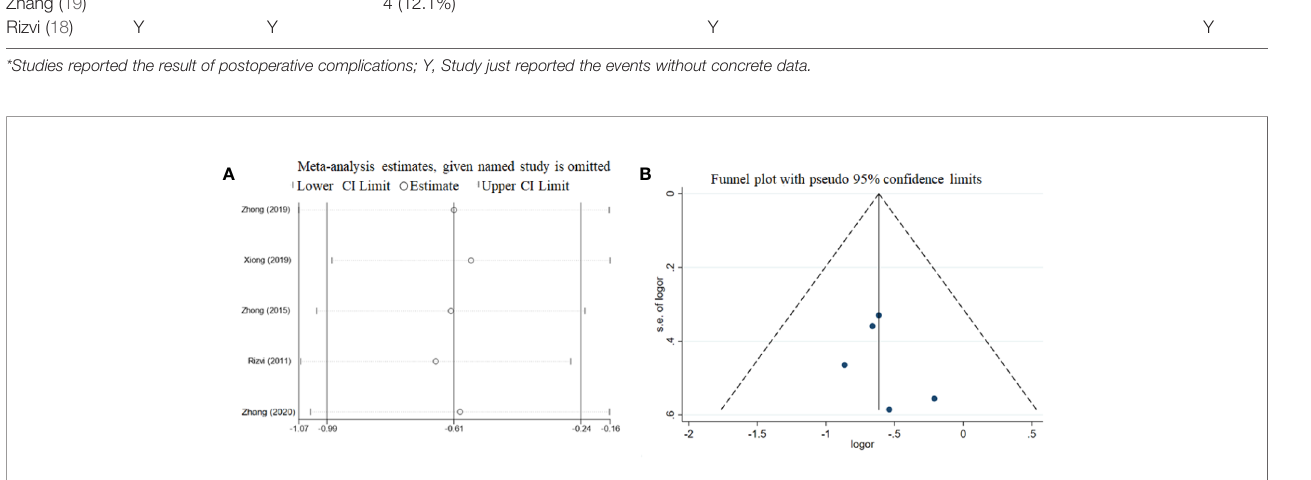
FIGURE 5 | Sensitivity analyses (A) and funnel plot (B) of the ORR among the included